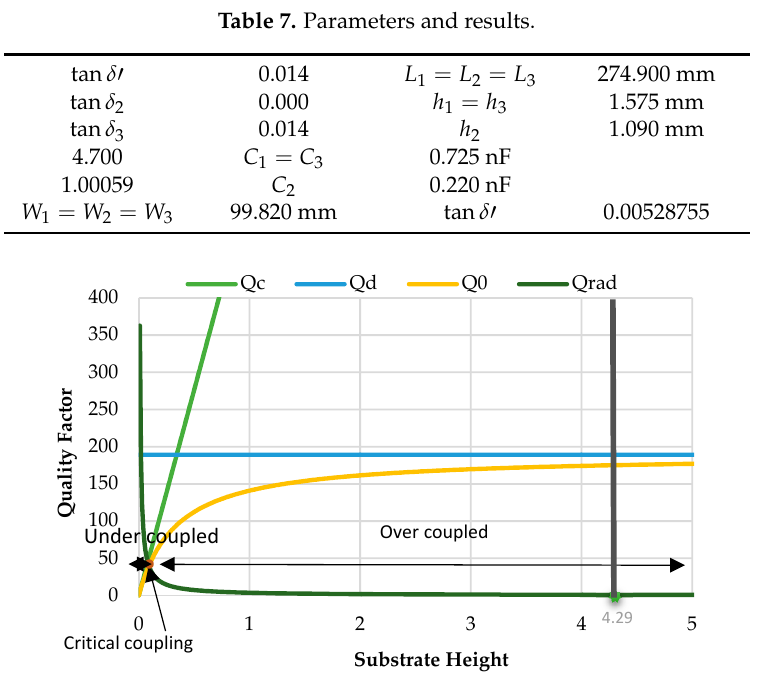
Table 7. Parameters and results.